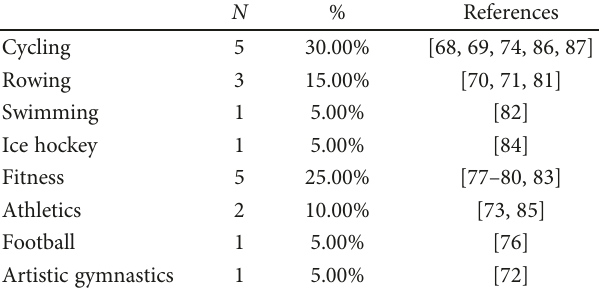
Table 9: Papers using muscle synergies in sports. N